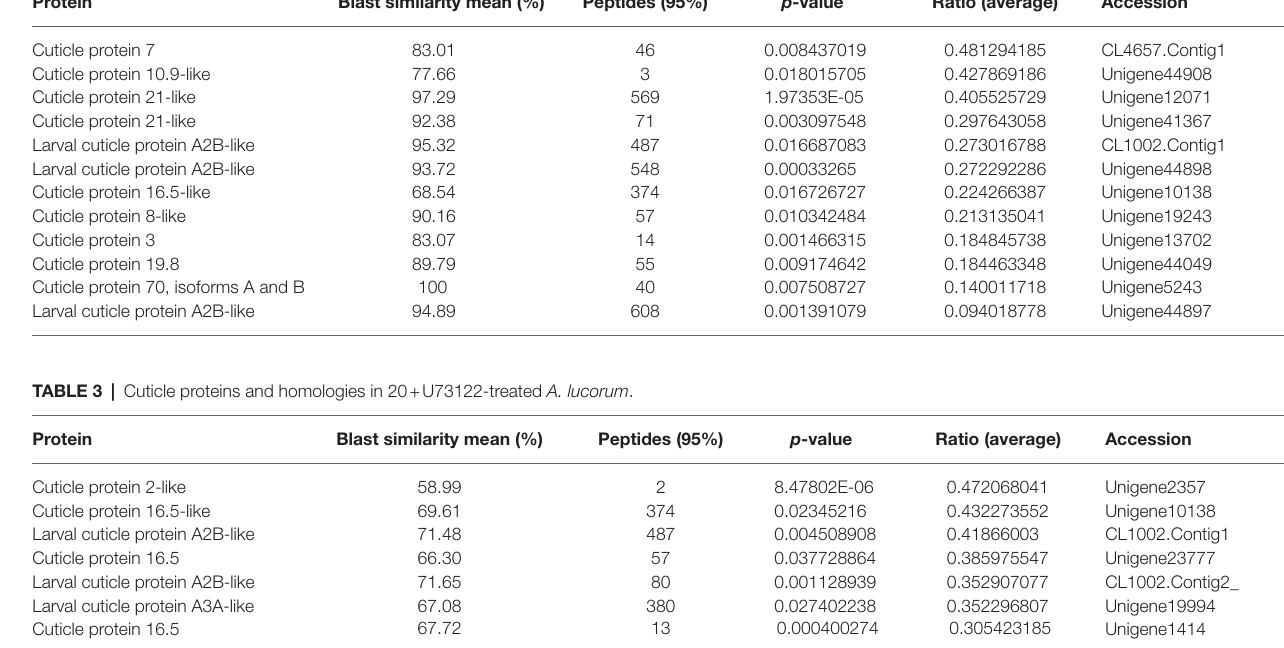
TABLE 2 | Cuticle proteins and homologies in U73122-treated A. lucorum . Protein Blast similarity mean (%) Peptides (95%) Cuticle protein